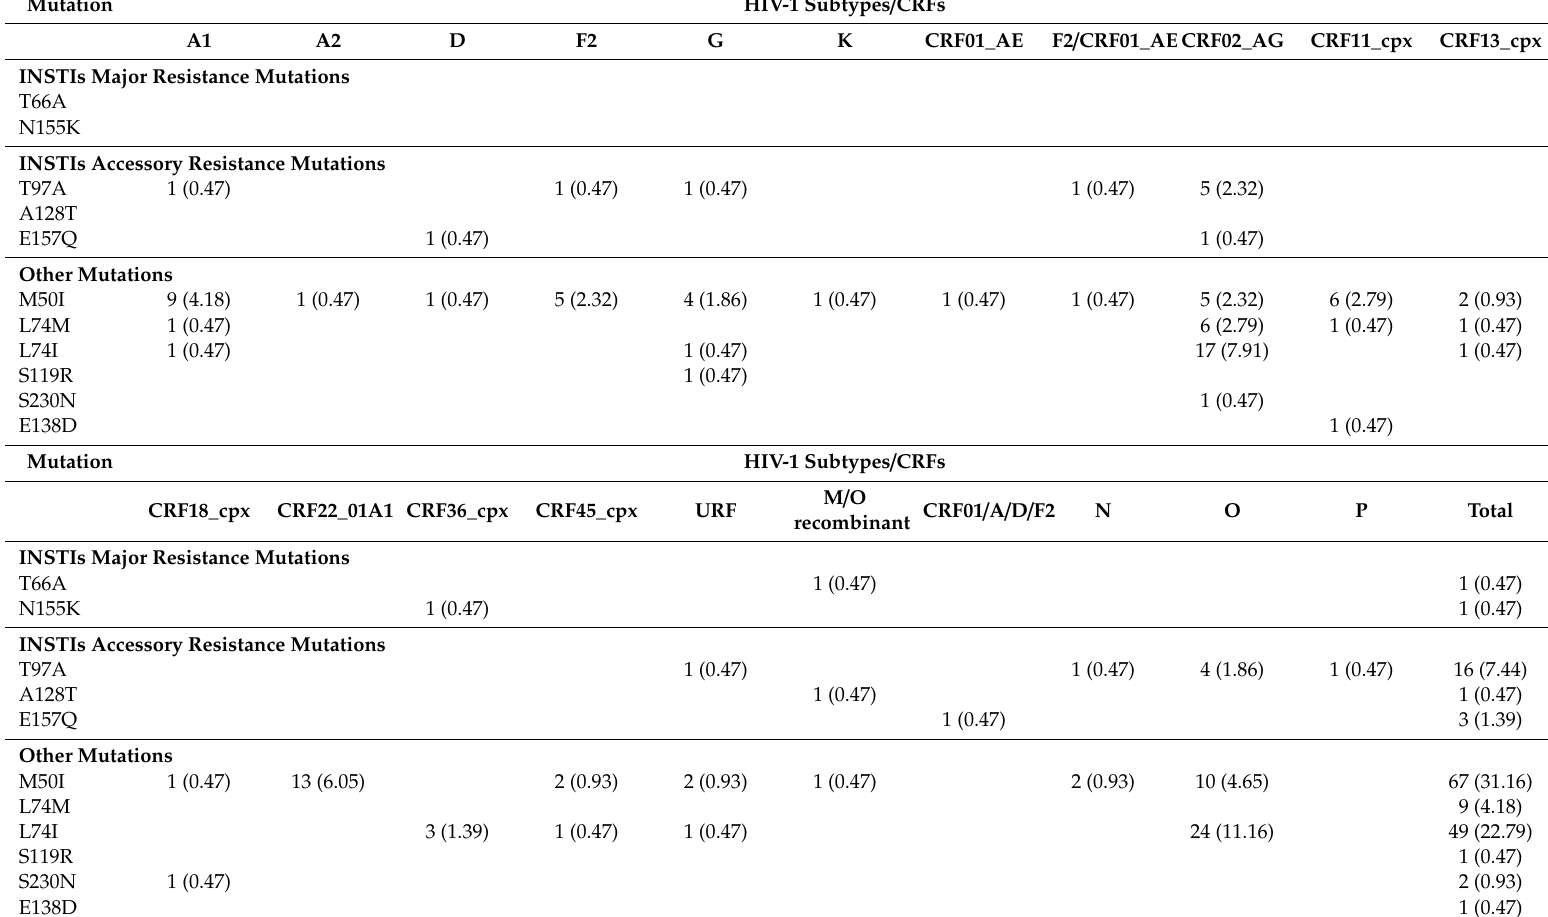
Table 3. Profile of INSTIs drug resistance mutations of database